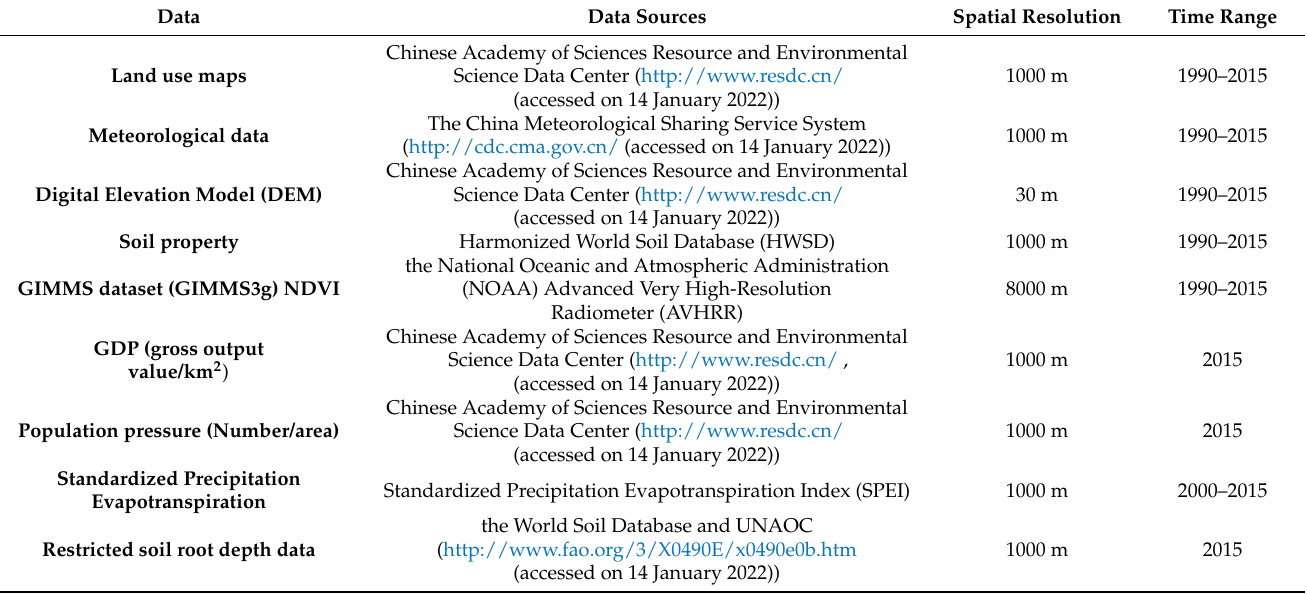
Table 2. Data sources and their spatial and temporal